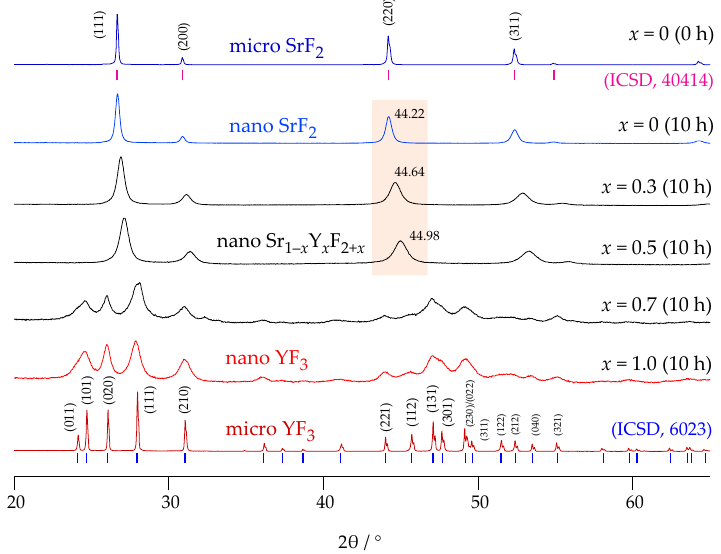
Figure 2. X-ray powder diffractograms recorded (CuK α 1 , 1.54059 Å) to characterize the phase purity of the starting materials as well as that of the mixed phases formed. The periods indicated in brackets show the milling times. The patterns of microcrystalline SrF 2 and YF 3 perfectly match with those in literature; verticals bars show the average positions of the CuK α 1 and CuK α 2 reflections. The broadening of the reflections, which is evident for the milled samples, indicates nm-sized crystallites; lattice strain and a distribution of lattice constants due to cation mixing may contribute to the broadening effect seen as well. Mixing of the cations is anticipated to have a much larger effect on ionic conductivity than the decrease in crystallite size seen when going from x = 0 to x = 0.3. See text for further